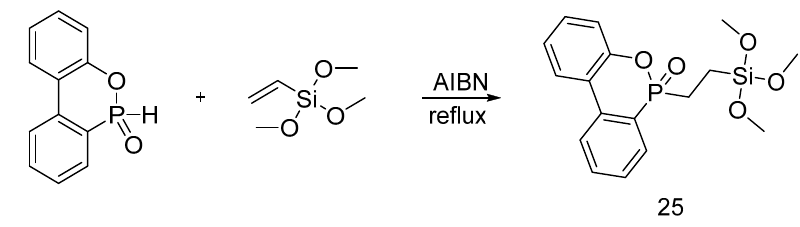
Figure 17. Synthesis of hybrid organic-inorganic flame retardant ( 25 ).